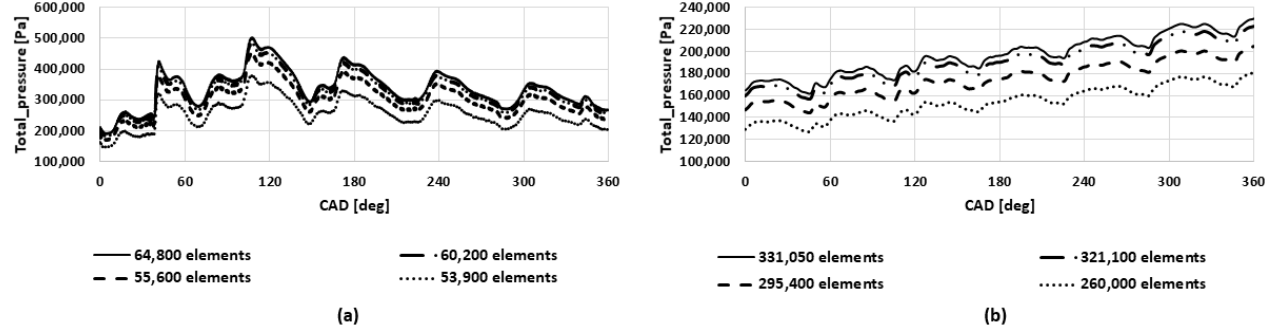
Figure 13. The mesh validation of ( a ) exhaust pipes and ( b ) VTG vanes.